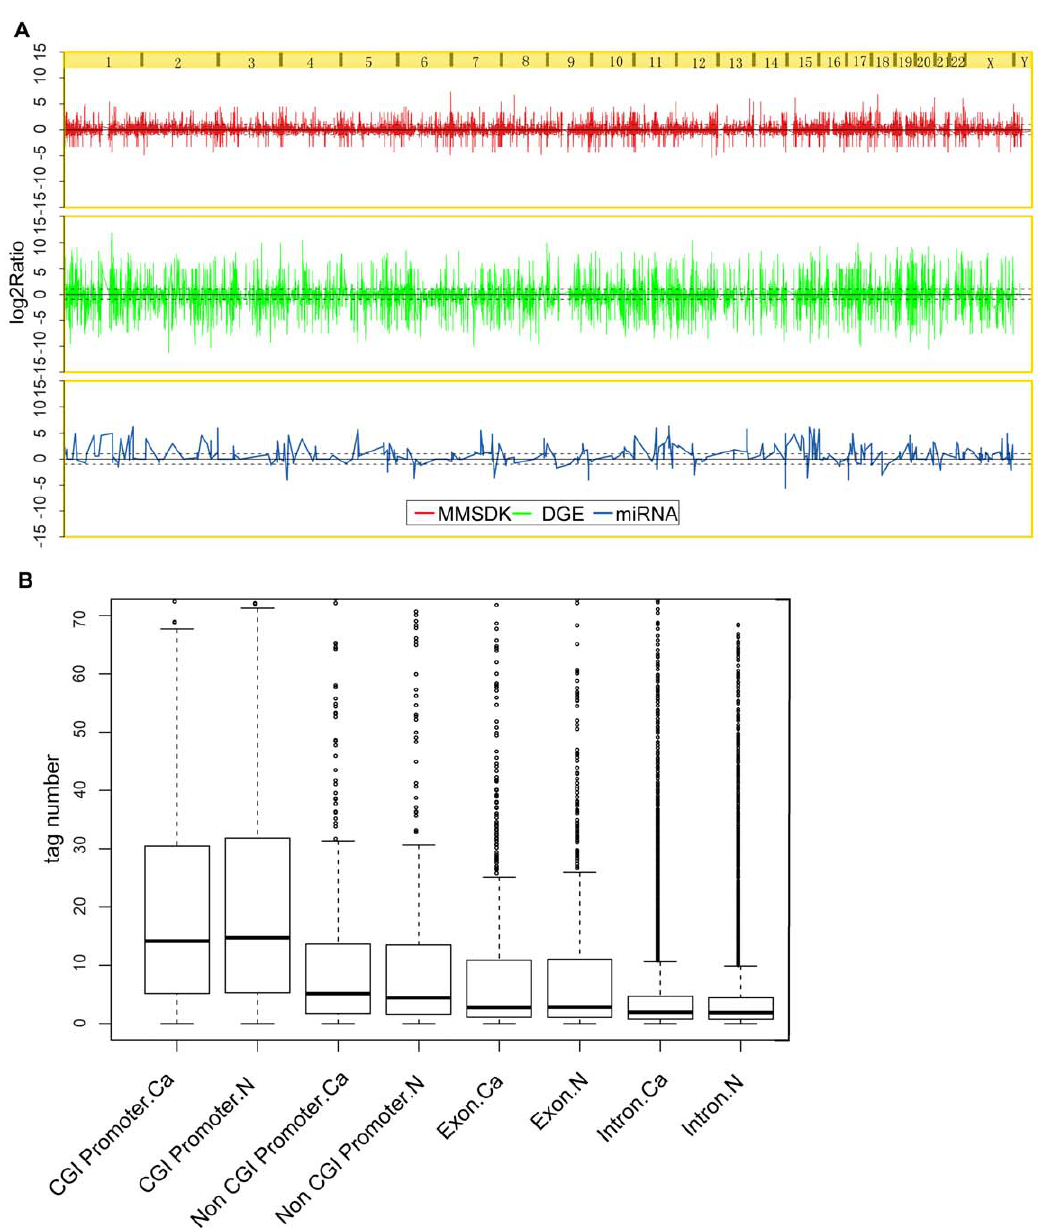
Figure 1. Overview of DNA methylation patterns in relation to gene expression. A. Genome wide DNA methylation, mRNA, and miRNA profiles from bladder cancer tissues and matched normal adjacent tissues. The log2-transformed average fold changes (tumor/normal) for methylation status (red), mRNA expression level (green), and miRNA expression level (blue) from all patients were drawn across the whole genome. The y-axis represents the log2 ratio, and the dashed lines represent the significance threshold (|log2Ratio|=1). B. Distribution of the methylation levels in different types of genic regions between bladder cancer tissues and matched normal adjacent tissues. The box-plots for the distribution of DNA methylation levels based on the log2-transformed tag fold change (tumor/normal) from MMSDK across all patients were drawn. Types include CpG-rich promoters, CpG-poor promoters, exons, and introns.